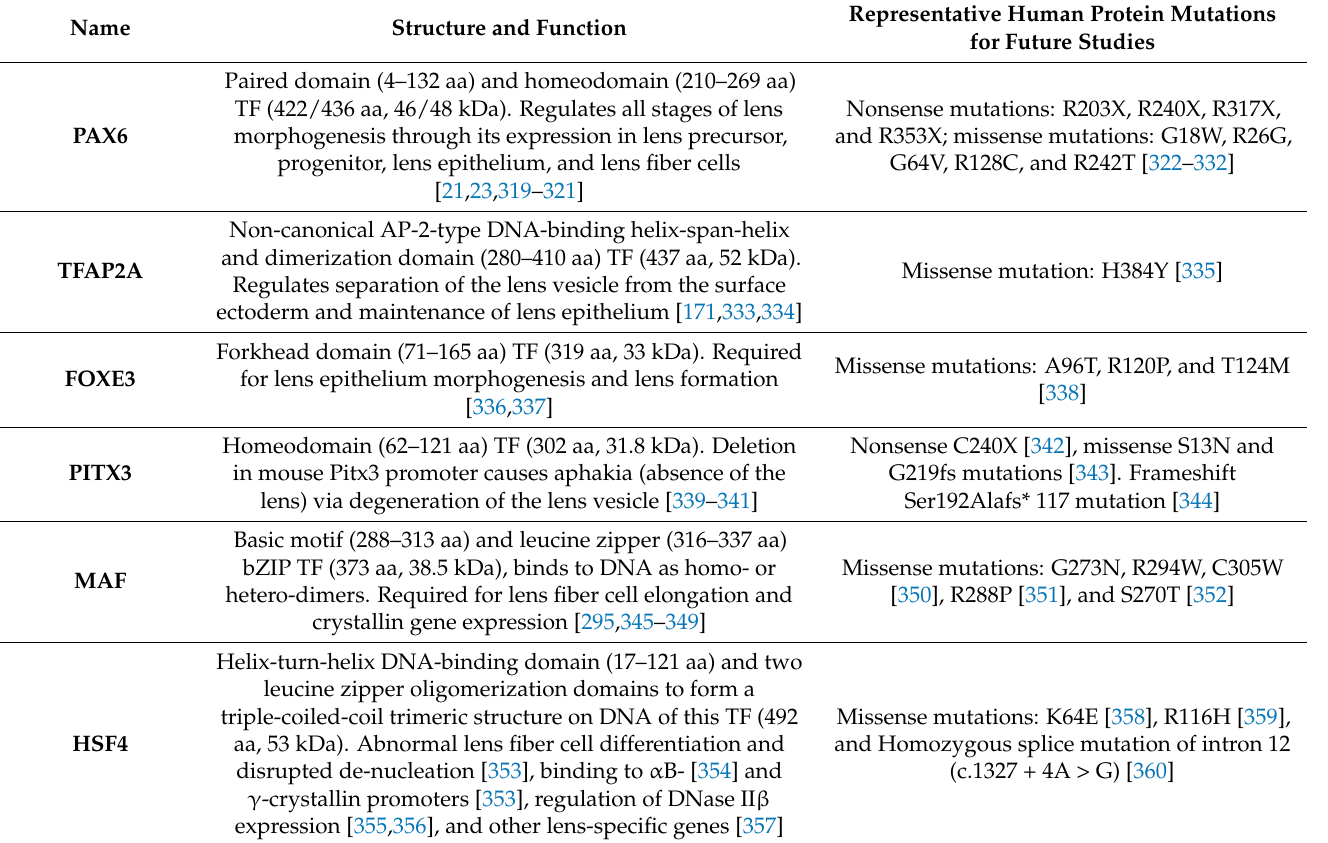
Table 4. Examples of model transcription factors (TFs) and their roles in lens